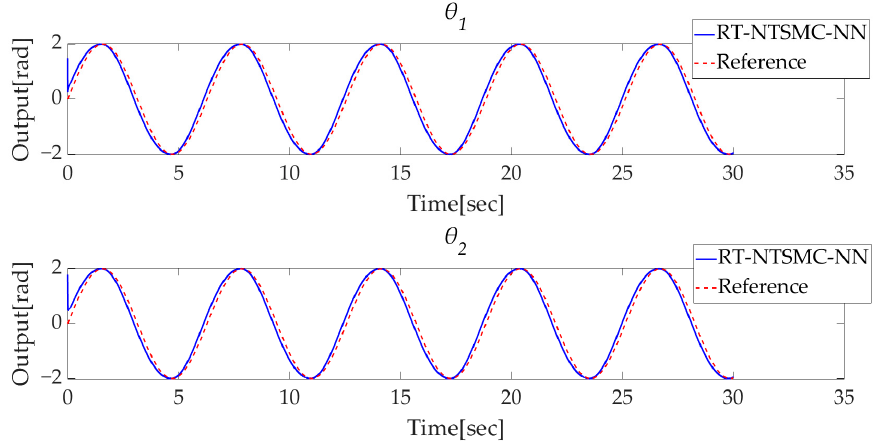
Figure 10. RT-NTMSC-NN control performance for continuous input.